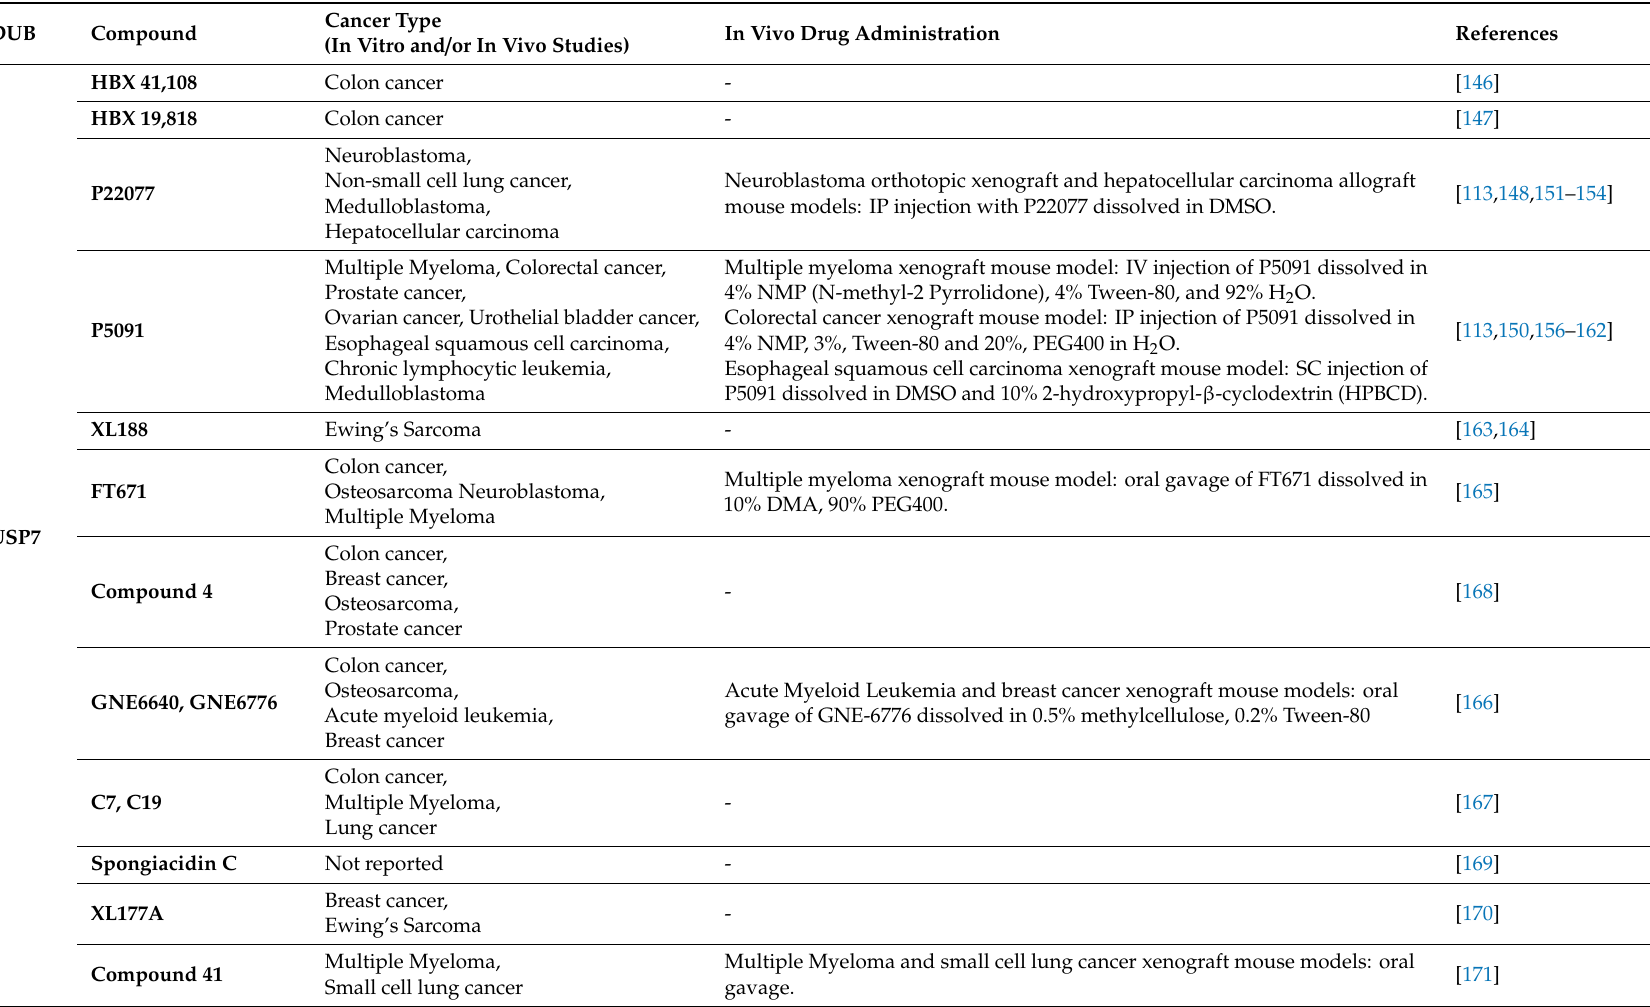
Table 1. Inhibitors of HH-related